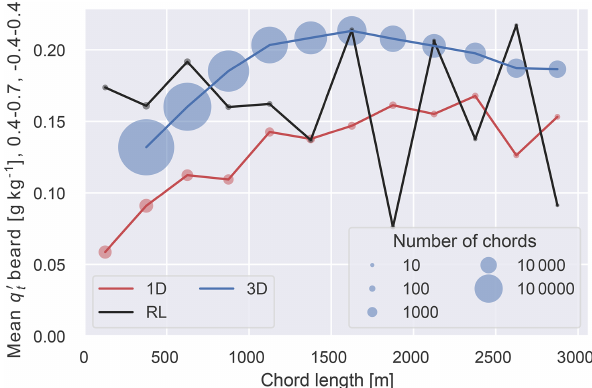
Figure 11. Mean water vapor anomalies below chord base as a func- tion of chord length. The area over which the anomaly is averaged is marked by the grey box in Fig. 10. The size of the markers rep- resents the number of chords in that 250m bin. Note that there is no 3D value for chords below 250m as we only compute scenes for chords with at least 10 data points as explained in Sect. 2.